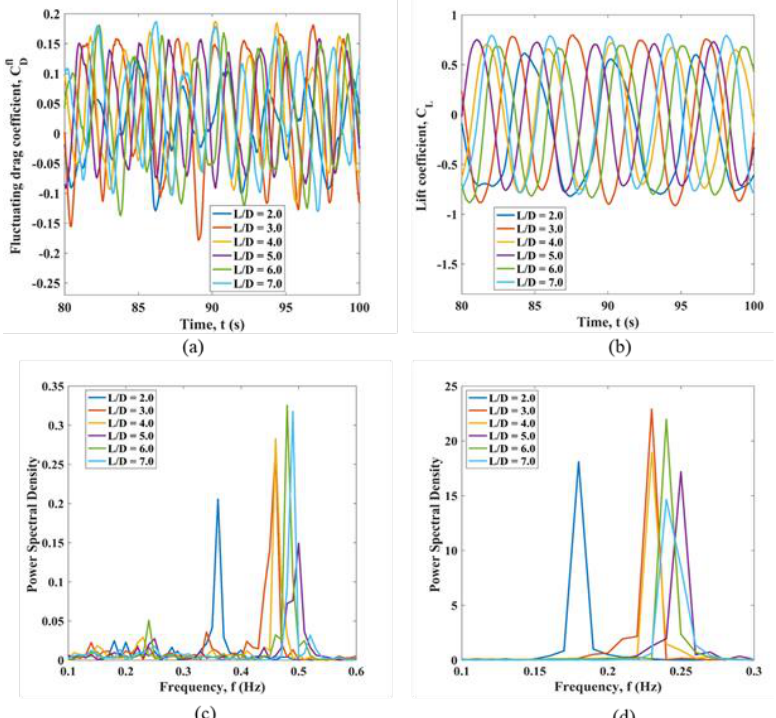
Figure A8. Fluid force coefficients for cylinder 4 immersed in planar sheared flow: ( a ) time history of the fluctuating drag coefficient; ( b ) time history of the lift coefficient; ( c ) the fluctuating drag co–efficient FFT; ( d ) the lift coefficient FFT.